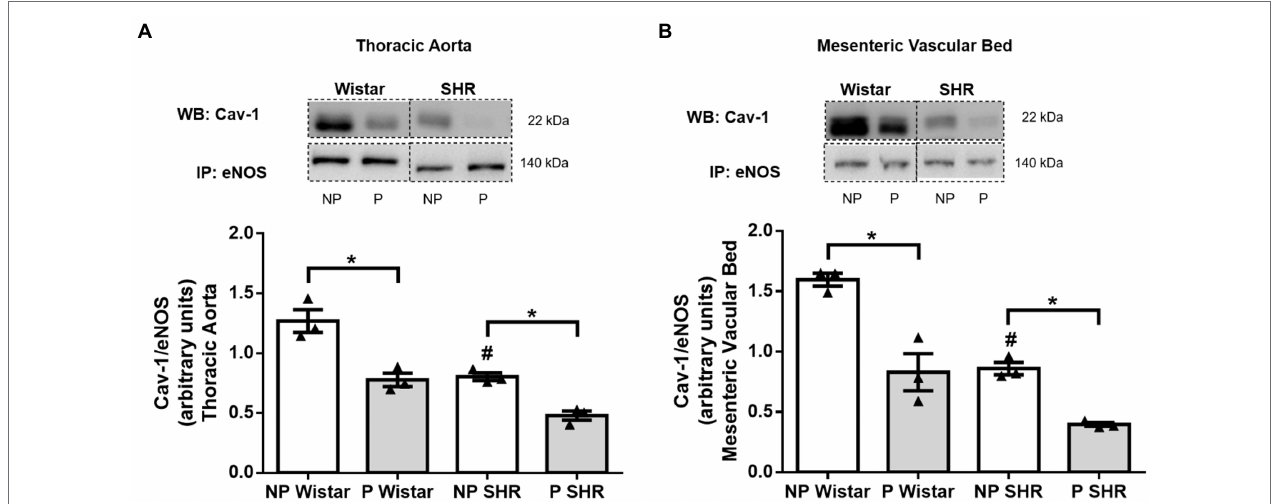
FIGURE 7 | Analysis of Cav-1/eNOS interaction by co-immunoprecipitation (Co-IP) of endothelial nitric oxidase synthase (eNOS) associated with caveolin-1 (Cav-1) immunoblot (WB) in the aorta (A) and resistance mesenteric bed (B) of non-pregnant (NP) and pregnant (P) Wistar and spontaneously hypertensive (SHR) rats. The bars represent the mean ± SEM of the results obtained in pools of the aorta and mesenteric bed ( n = 3) from the different groups. * p < 0.05 P versus NP groups; # p < 0.05 NP SHR versus NP Wistar